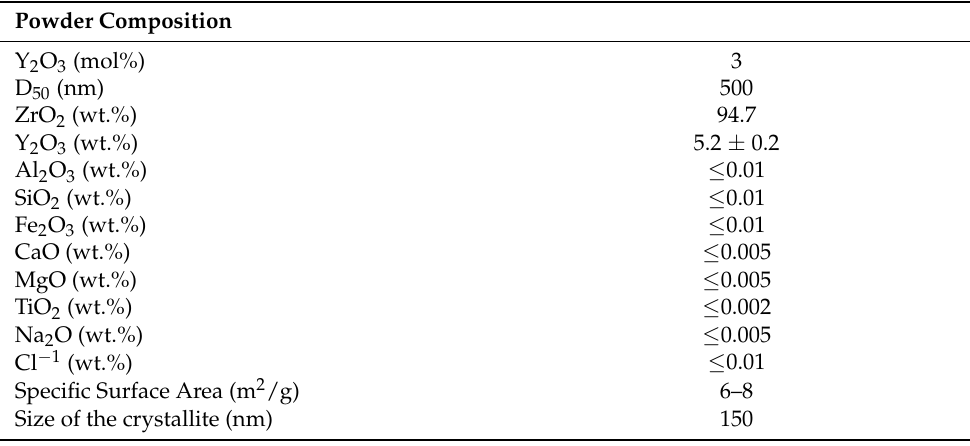
Table 2. Material composition as per